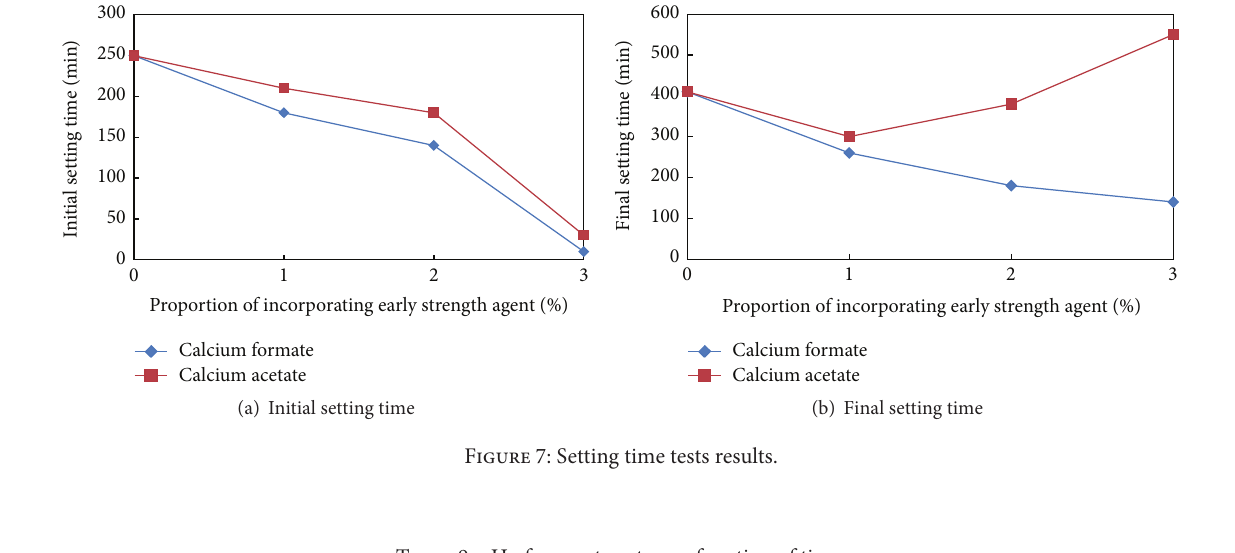
Table 9: pH of cement paste as a function of